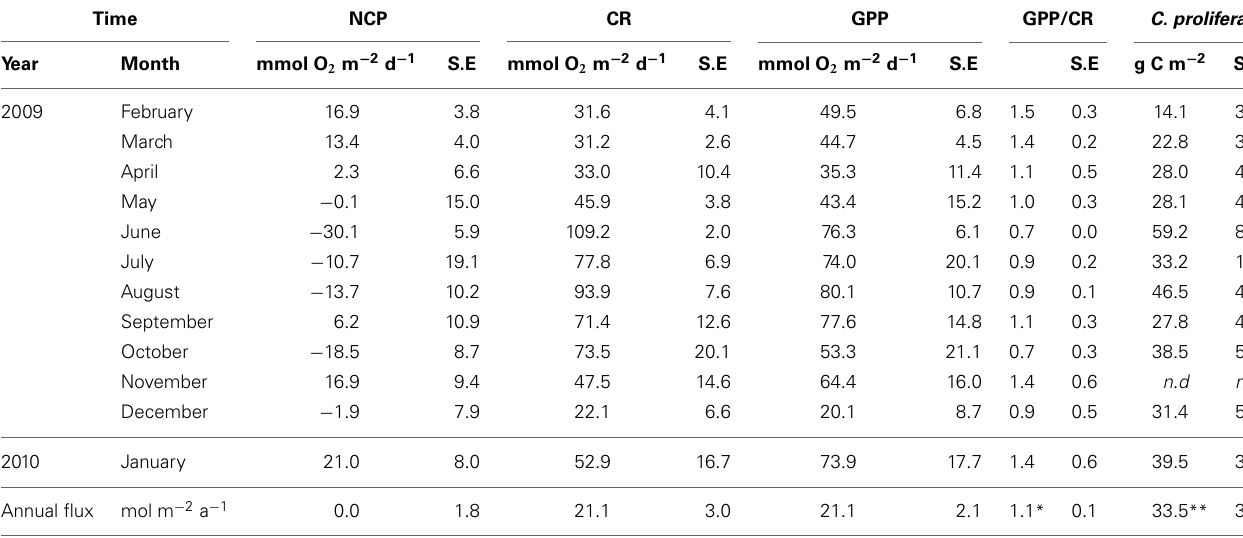
Table 3 | Community metabolism (NCP, CR and GPP), GPP/CR ratio and the biomass of C. prolifera over time in the bay of